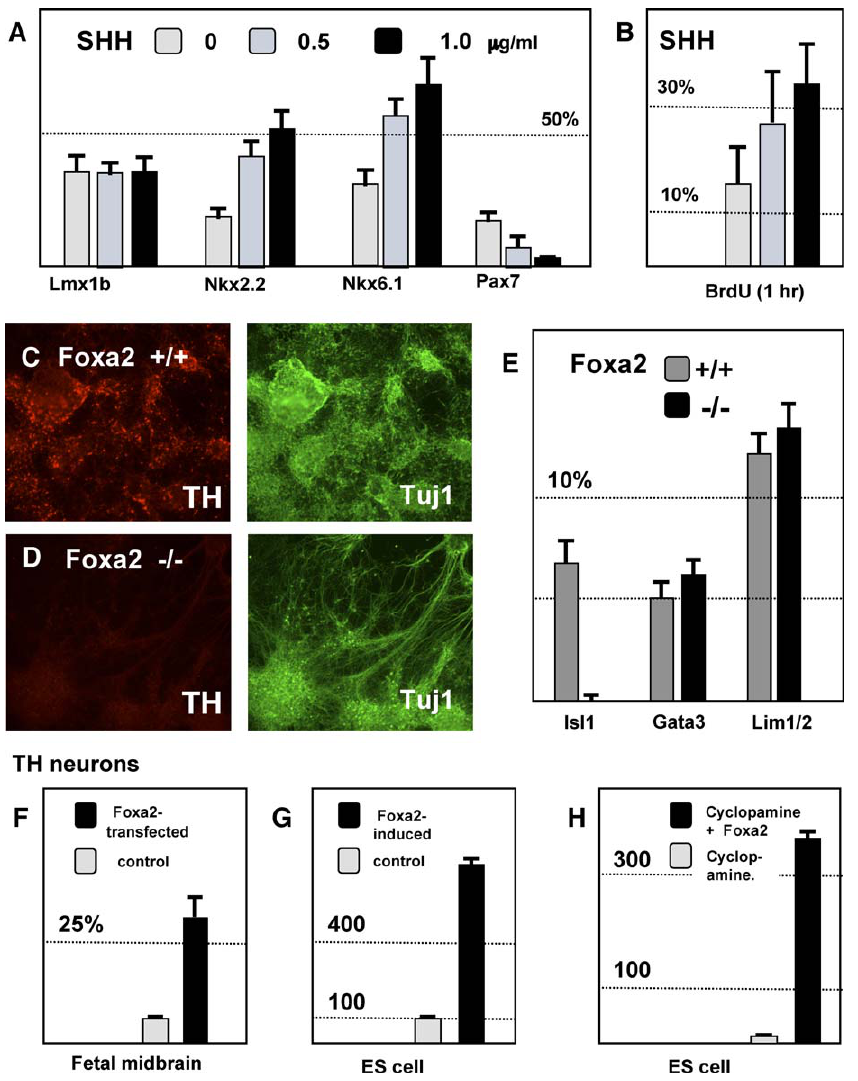
Figure 2. The In Vitro Role of foxa2 and SHH in Cell Fate Specification in the Ventral Mesencephalon (A) Effects of Shh on E8.5 mesencephalic precursors in vitro. In the absence of exogenous SHH, many LMX1b þ precursors (36.59 6 6.10%) were observed. NKX2.2 þ (19.83 6 4.39%), NKX6.1 þ (30.47 6 6.72%), and PAX7 þ precursors (16.33 6 5.02%) were present. In the presence of 500 ng/ml of SHH protein, the proportion of NKX2.2 þ (41.84 6 5.84%) and NKX6.1 þ (56.62 6 7.04%) cells increased, whereas, the proportion of PAX7 þ cells diminished (6.89 6 2.54%). Despite these effects on other cell types, the proportion of LMX1b þ dopamine precursors was stable (32.48 6 5.56%). Higher concentrations of SHH would be expected to further ventralize the midbrain precursors at the expense of more dorsal fates. In the presence of 1 l g/ml of SHH protein, there was a further increase in NKX2.2 þ and NKX6.1 þ cells (nkx2.2 þ , 52.75 6 6.34%; nkx6.1 þ , 69.12 6 8.73%) and a greater reduction of PAX7 þ cells (2.24 6 0.81%). At this high concentration of SHH, the percentage of dopamine precursors again remained unchanged (33.04 6 6.61%). (B) SHH has a proliferative effect on mesencephalic precursors in cell culture. BrdU was added to day 3 cultures of mesencephalic precursors, grown in different concentrations of SHH protein. BrdU was added for 1 h before fixation and staining. The percentage of cells incorporating BrdU increased with the concentration of SHH in the culture. (C) Wild-type mesencephalic explants differentiate to generate a large number of neurons (Tuj1, green) and a significant proportion of these neurons express tyrosine hydroxylase (TH, red). (D) Mesencephalic explants from foxa2 (cid:2) / (cid:2) embryos also generate many neurons, but TH expression is absent. (E) foxa2 (cid:2) / (cid:2) explants similarly do not yield islet-1–expressing motor neurons although the differentiation of GATA3- and LIM1/2-positive neurons born outside of the floor plate is unaffected. The developmental expression pattern of these proteins can be seen in Figure S3. (F) Overexpression of foxa2 in cultured E10.5 mesencephalic explants results in an increase in TH-expressing dopamine neurons. (G) Doxycycline induction of foxa2 in differentiating F4 mouse embryonic stem cells significantly increases the number of resulting dopamine neurons. (H) Inhibition of SHH signaling by cyclopamine suppresses dopaminergic differentiation of ES cells. The induction of foxa2 by doxycycline overcomes cyclopamine suppression of dopamine neuron